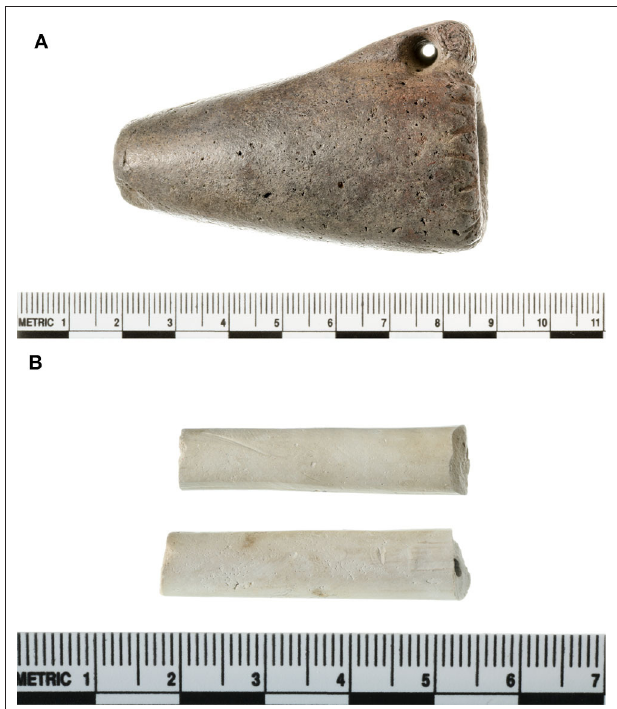
FIGURE 1 | The ancient pipes analyzed in this study. The pre-contact pipe ( A ; Washington State University-Museum of Anthropology Inventory Number: 45GR27.116; PIPE_116) and post-contact pipe ( B ; Washington State University-Museum of Anthropology Inventory Number: 45WW6.108; PIPE_108) are roughly 7.0 and 4.0cm in length,